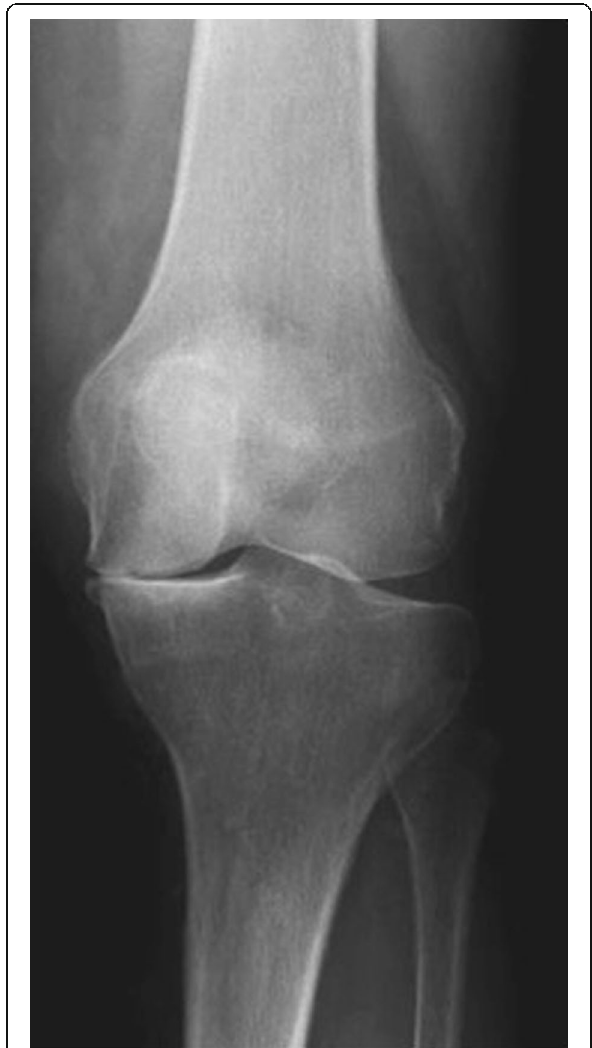
Fig. 4 X-ray post subtotal meniscectomy. Forty two year old man: X-ray of a left knee joint 7 years after subtotal meniscectomy. It shows a lost joint line on the medial site and signs of osteoarthritis of the knee (published in (Zellner & Angele,